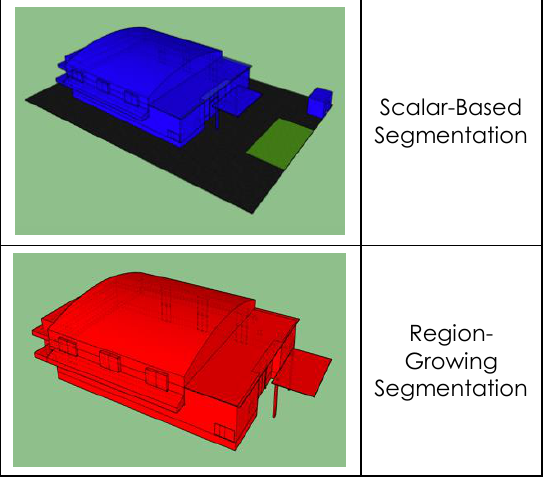
Table 2: 3D Model of Segmented